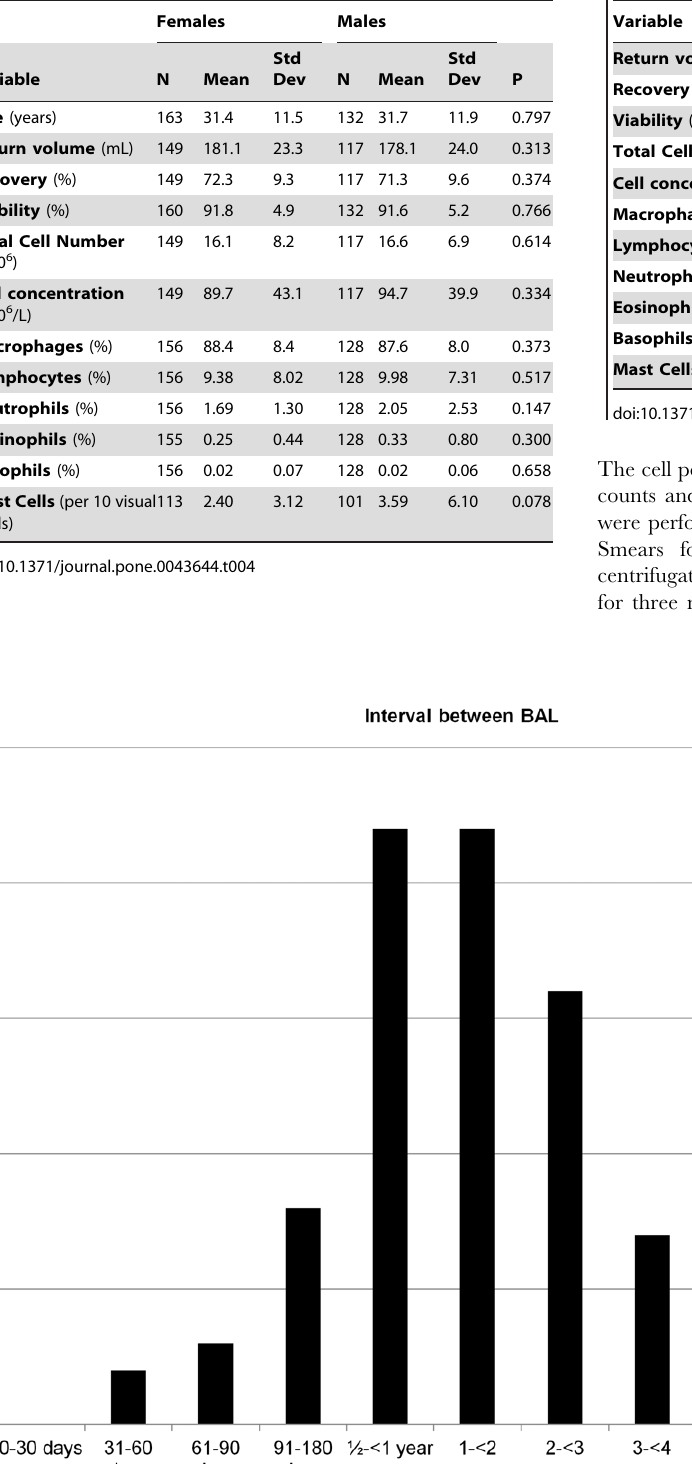
Variable N Std Dev Normal variability